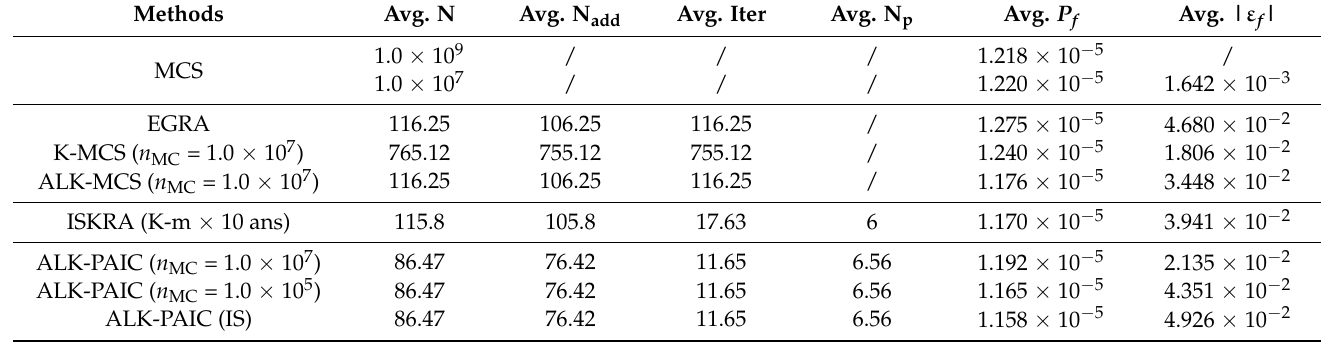
Table 1. The results of four branches case by different methods.